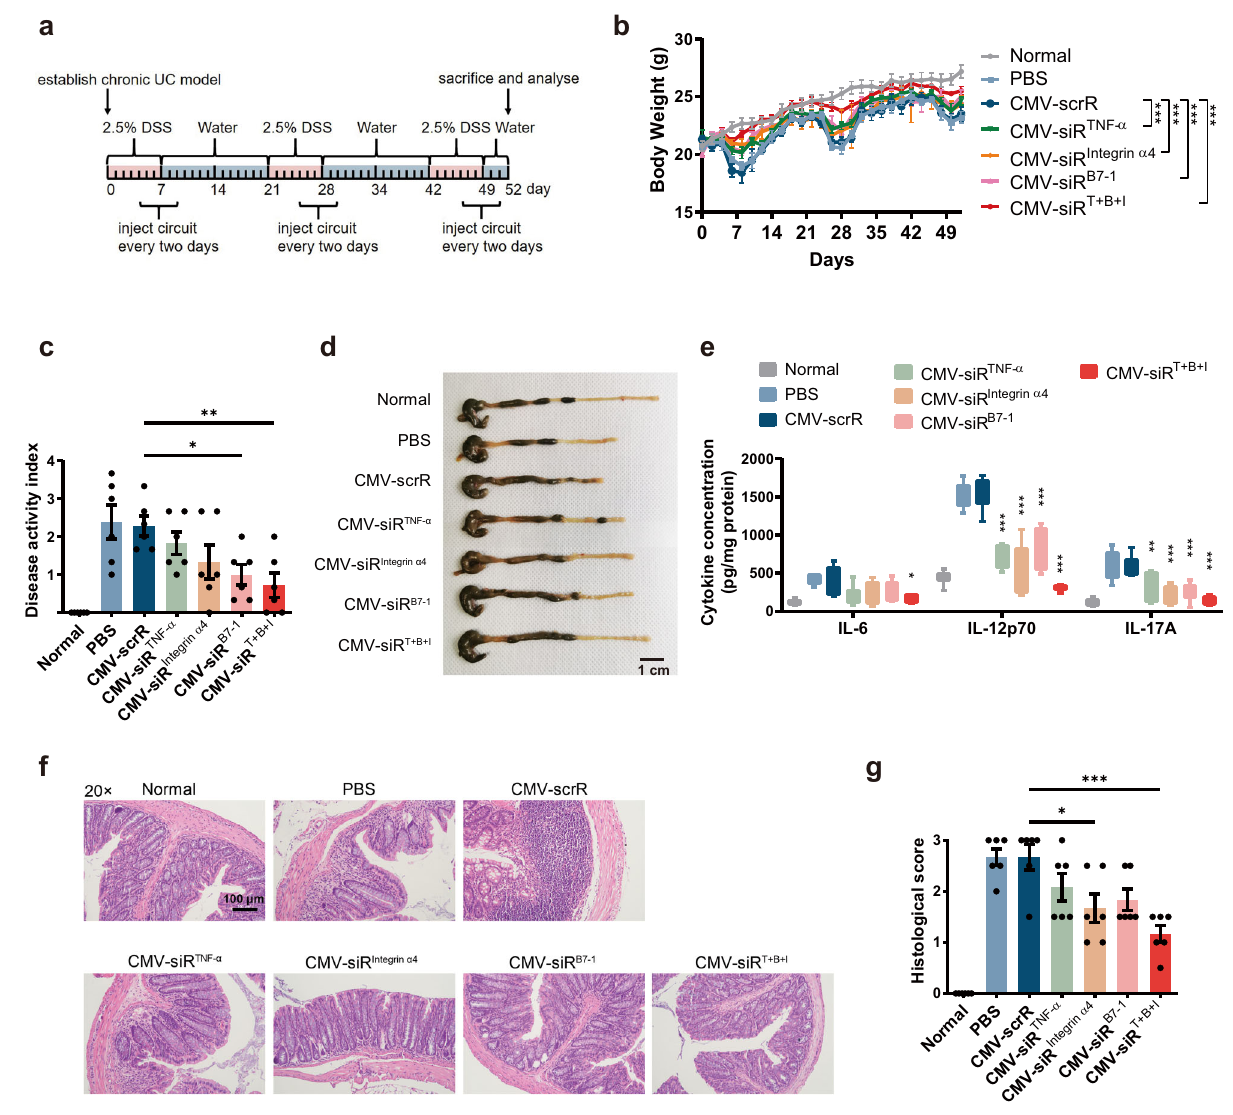
Fig. 7 | Intravenous injectionofthemulti-targeted CMV-siR T+B+I circuitexerts a synergistic therapeutic effect against DSS-induced chronic UC. a Flow chart of the experimental design. b Body weight curves ( n =6 in each group). c DAI scores ( n =6 in each group). d Representative macroscopic features of colons. Scale bar: 1cm. e Determinationofserum levels of IL-6, IL-12p70and IL-17A by ELISA( n =6in